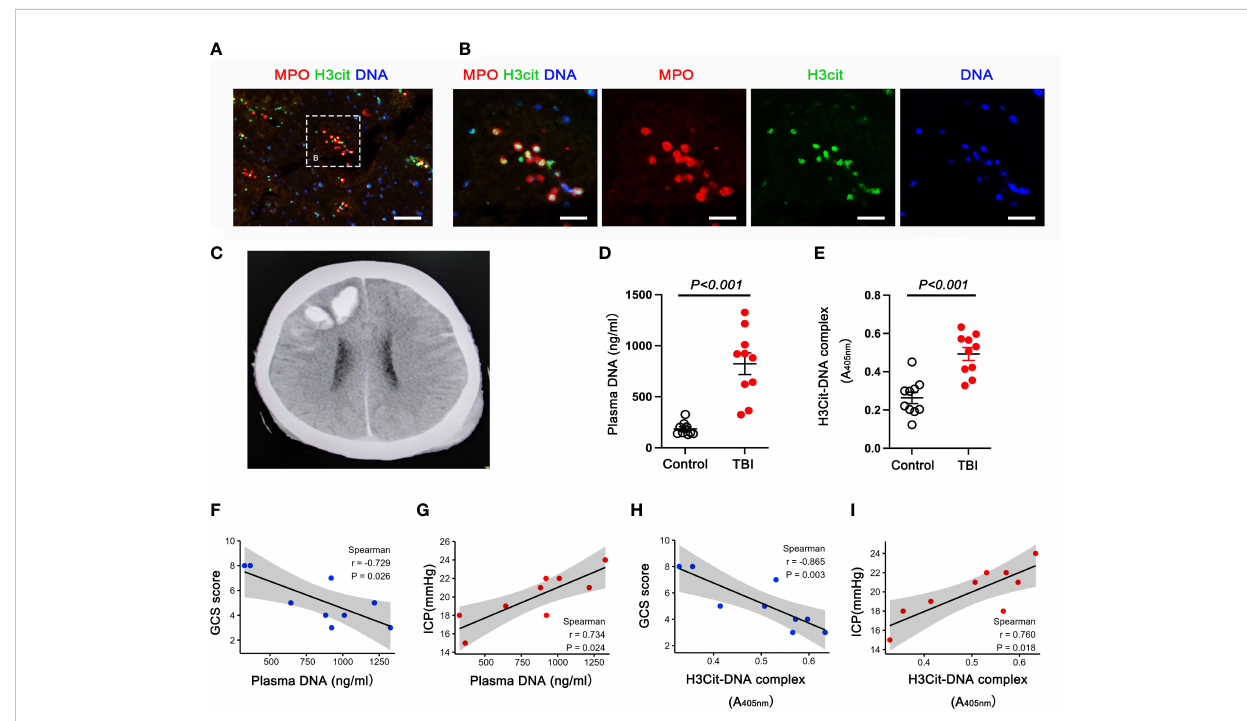
FIGURE 1 NETs are found in the brain and circulating blood from TBI patients and have a signi fi cant correlation with GCS and ICP. (A, B) Representative immuno fl uorescence images (A) displaying the NET formation (H3Cit-positive neutrophils) in the brain tissue sections from TBI patients. Enlarged images on the right side (B) . Scale bar = 50 m m (A) ; Scale bar = 200 m m (B) . A representative CT image from a TBI patient (C) . The image shows the right frontal contusion and hematoma. (D, E) Quanti fi cation of the Levels of plasma DNA (D) , plasma H3Cit-DNA complex (E) in the peripheral blood from healthy donors (n = 10) and TBI patients (n = 10). (F-I) Correlation among the levels of plasma DNA, plasma H3Cit-DNA complex with Glasgow Coma Scale (GCS) and intracranial pressure (ICP). Spearman correlation analysis was applied with r=-0.729, P =0.026 (F) (plasma DNA correlate with GCS score), r=0.734, P =0.024 (G) (plasma DNA correlate with ICP), r=-0.865, P =0.003 (H) (plasma H3Cit-DNA complex correlate with GCS score), r=0.734, P =0.024 (I) (plasma H3Cit-DNA complex correlate with ICP). The statistical graph shows that the higher the level of NETs, the greater the degree of